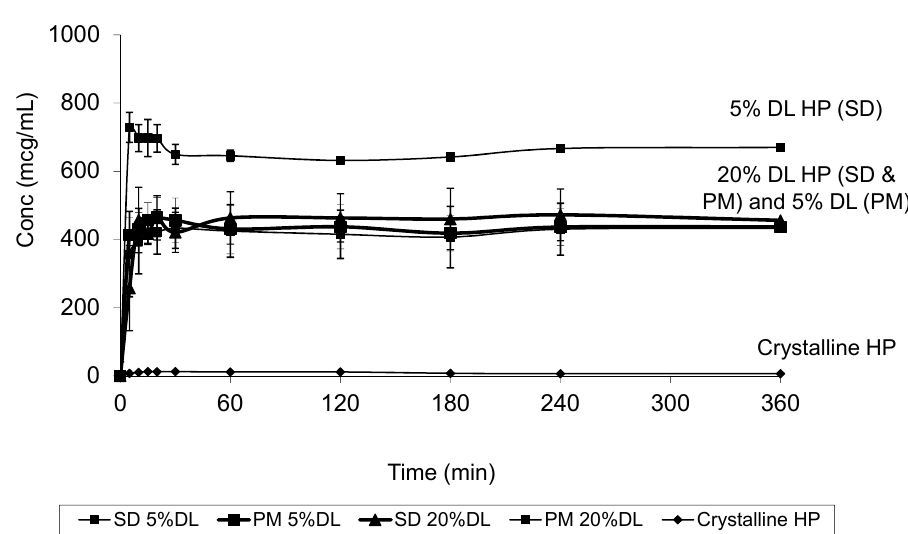
Figure 11. Dissolution profile of crystalline HP, HP PVPK30 solid dispersion (SD) and physical mixture (PM) at 5% and 20% drug loading (DL).